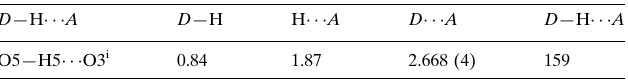
Hydrogen-bond geometry (A ˚ , (cid:2)